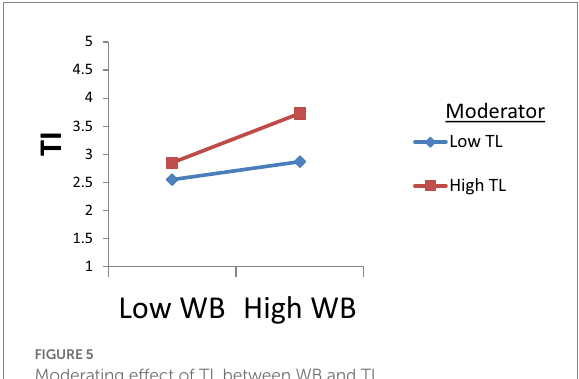
FIGURE 5 Moderating effect of TL between WB and TI.